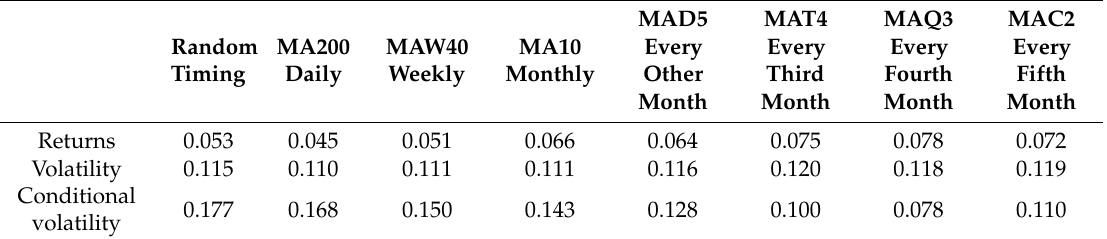
Table 1. The 200 trading-day rolling window, average annualized returns, volatilities, and conditional volatilities in Dow Jones Industrial Average (DJIA) index, 4 January 1988 to 31 December